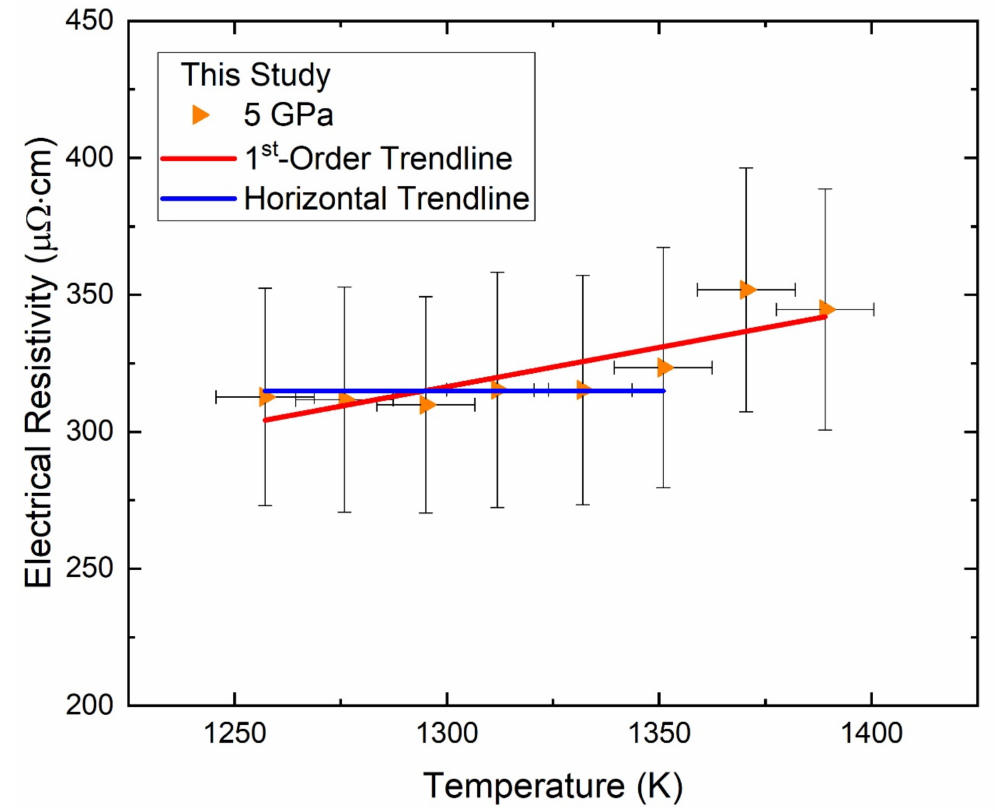
Figure A1. A first-order polynomial (red) was fitted to eight measurements and a horizontal line (315 µ Ω · cm; blue) was fitted to six measurements of the 5 GPa experiment. Both fits were used to interpolate and extrapolate the values of electrical resistivity for temperatures from 1250 K to 1450 K. The values obtained from these fits were used to calculate the adiabatic conductive heat flow for the core of Ganymede described in the main